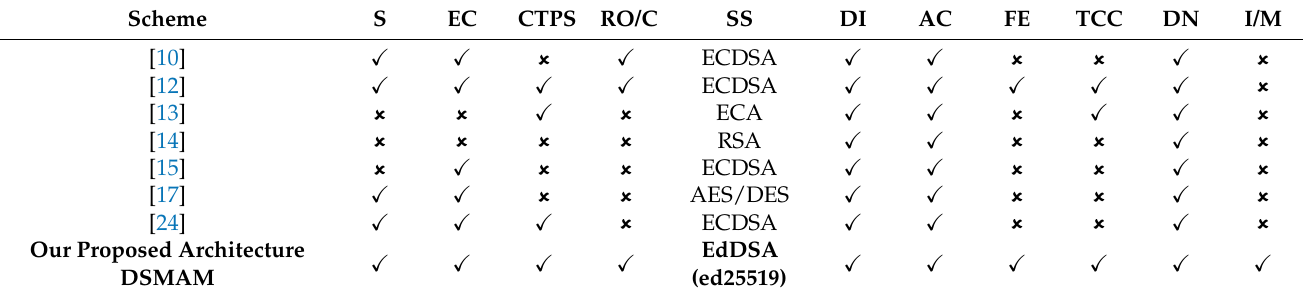
Table 6. Performance comparison based on defined parameters.